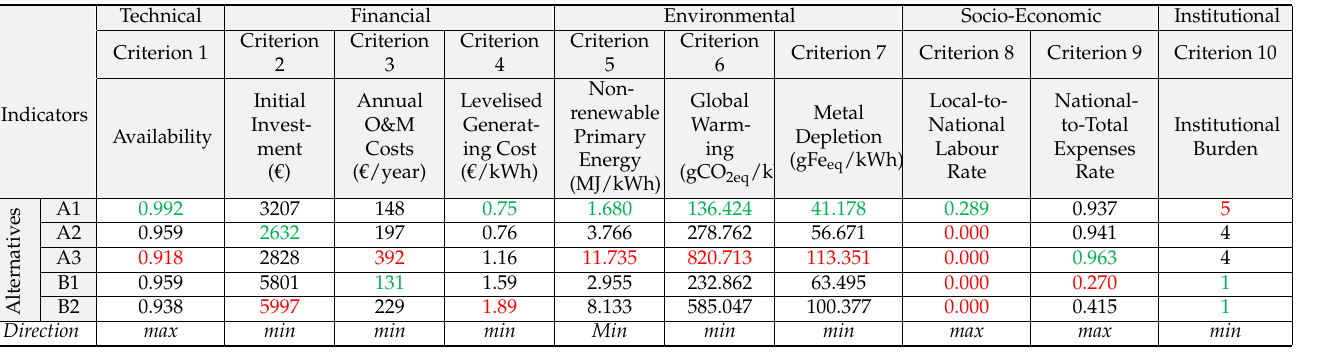
Table 2. Performance of the SWT alternatives in the sustainability criteria: for each criterion, best performance values appear in green colour, and worst performance values in red